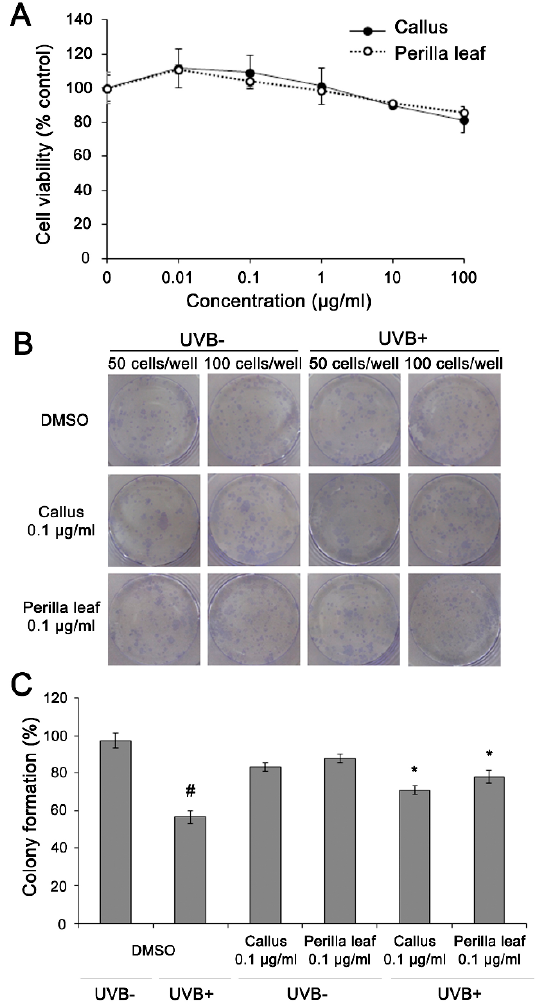
Figure 4. Perilla leaf and callus extracts prevented the suppression of HaCaT proliferation by UVB. ( A ) 3-(4,5-Dimethylthiazol-2-yl)-2,5-Diphenyltetrazolium Bromide (MTT) assay of HaCaT cells treated with Perilla leaf and callus extracts. Results are expressed as means ± SDs. Different letters indicate significantly different ( p < 0.05) by Duncan’s test. ( B , C ) HaCaT cells were treated with Perilla leaf or callus extracts (0.1 μ g/mL) overnight, irradiated with UVB (30 mJ/cm 2 ), har- vested, and reseeded at 50 or 100 cells/well in 6 well plates. Colony formation was observed 14 days after seeding. ( B ) Representative colony-forming assay images after methanol fixation and crystal blue staining. ( C ) Colony numbers were counted and recorded. Colony formation rates of HaCaT cells (determined by analyzing 50 cells/well). Results are presented as the means ± SDs of three plates. # p < 0.05 versus UVB non-treated and DMSO controls. * p < 0.05 versus the UVB treated and DMSO controls. 3.5. Perilla Leaf and Callus Extracts Enhanced DNA Repair Signaling and Protected HaCaT cells from UVB-Induced Cell Cycle Changes Perilla leaf and callus extracts enhanced the levels of pCHK1(S345) protein (an in- ducer of DNA repair signaling) more than DMSO treatment in UVB exposed HaCaT cells (Figure 5A,B; Supplementary Figure S2). Moreover, Perilla callus extracts reduced levels of γ H2AX protein (a hallmark of DNA damage) more than Perilla leaf extract in UVB ex- posed keratinocytes (Figure 5B). These data suggest that Perilla callus extracts reduce DNA damage after UVB irradiation in keratinocytes.